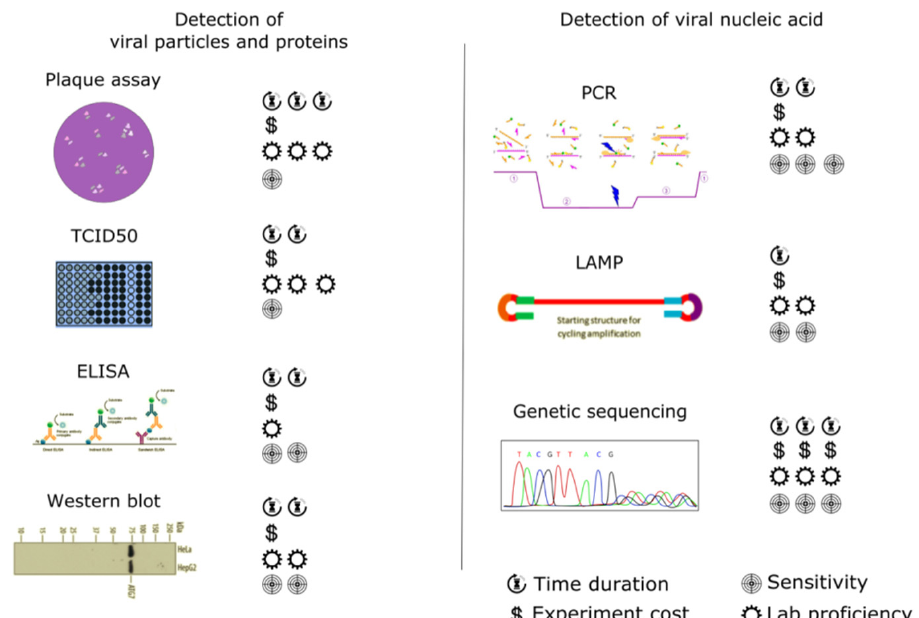
Figure 1. Comparison of currently used methods for the detection of viruses. The detection methods are divided into 2 subgroups differing in targeting various parts or molecules of the virus.